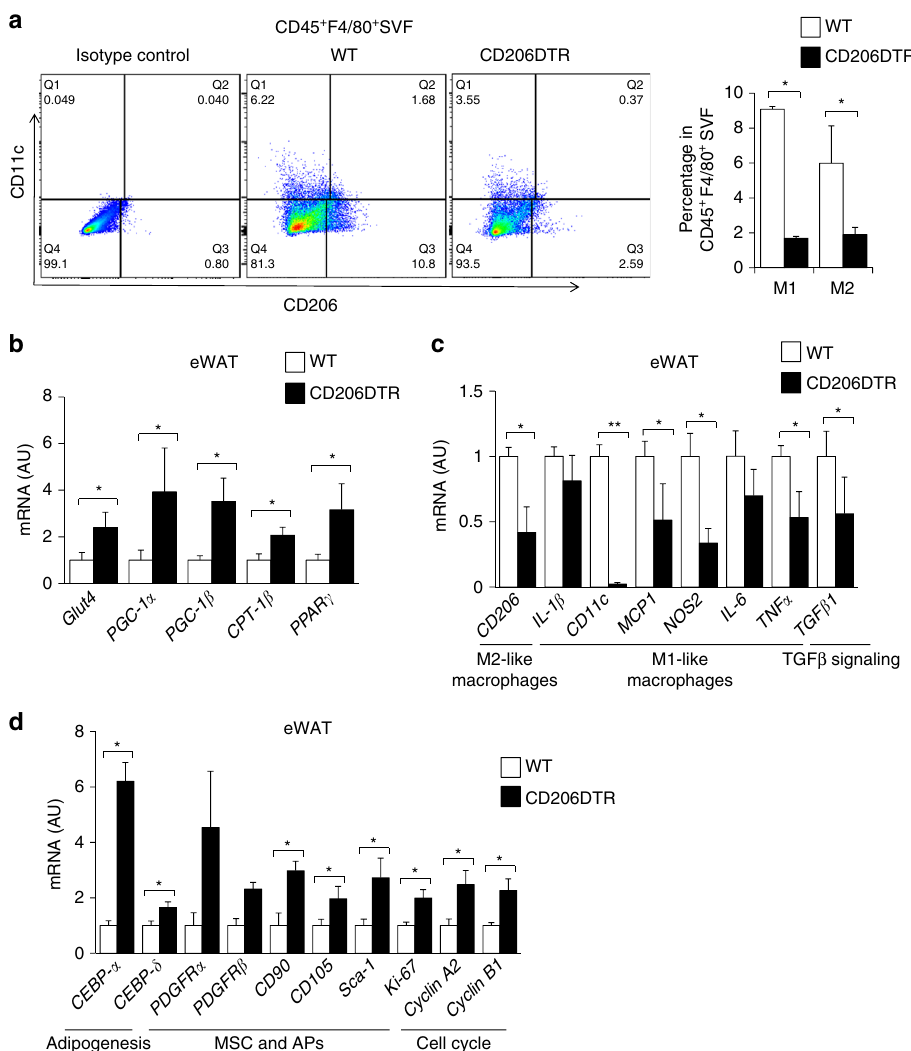
Fig. 9 Effects of CD206 + M2-like ATMs depletion on adipogenesis in obese mice. a Representative fl ow cytometry analysis of CD11c and CD206 expression in F4/80 + SVF cells of eWAT from WT and CD206DTR mice. Cells were also stained with isotype control antibodies for anti-CD11c and anti-CD206 antibodies ( left panel ). Percentages of M1- and M2-like macrophages in CD45 + F4/80 + SVF of eWAT from WT and CD206DTR mice were calculated ( right panel ). Full gating strategy is given in Supplementary Fig. 13a. b The relative mRNA expression of metabolic genes and c , d M1-, M2-like macrophages, adipogenesis, APs/MSC and cell cycle markers genes in eWAT of DT-treated HFD-fed CD206DTR and WT mice. ( n = 3 – 5 per group). The data are shown as the means ± SEM. * P < 0.05, ** P < 0.01. (H) The data are shown as the means ± SEM. * P < 0.05, ** P < 0.01 compared with littermates by Student ’ s t